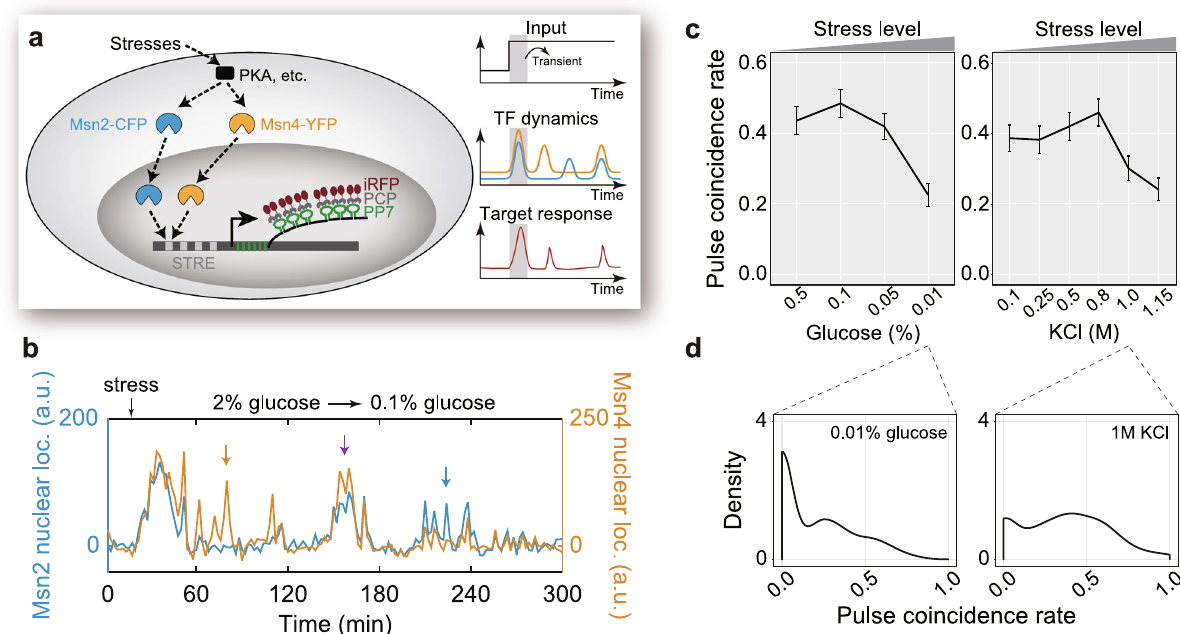
Fig. 1 Input modulates the temporal relationship between Msn2 and Msn4 pulses. a Schematics of the single-cell assay for monitoring Msn2/Msn4 dynamics (with fl uorescent protein fusions) and target responses (with the PP7-PCP system) in the same cell. Using micro fl uidics, both transient (shaded) and steady-state responses were recorded. b Example single-cell traces of Msn2 (blue) and Msn4 (orange) nuclear localization dynamics in response to a step change in glucose concentration. Coincident pulse (purple arrow) and noncoincident pulses (orange or blue arrow) are indicated. a.u., arbitrary unit. See also Supplementary Movie 1. c Pulse coincidence rates between Msn2 and Msn4 under different stress conditions. Cell numbers are 139, 176, 333, and 282 for glucose limitation stresses and 148, 182, 207, 181, 195, and 201 for osmotic stresses. Error bars indicate 95% con fi dence intervals (CIs) and centers indicate means. d Distributions of pulse coincidence rates in individual cells.